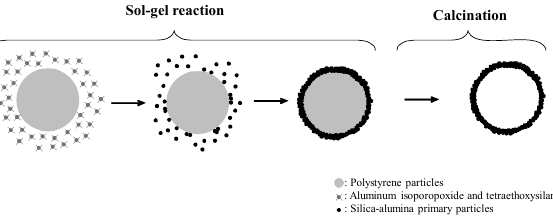
Fig. 1 Schematic illustration of the formation process of the hollow silica–alumina composite